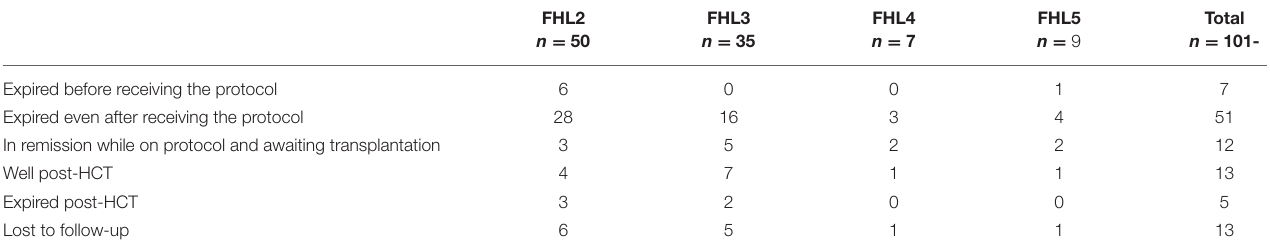
TABLE 3 | Outcome of therapy seen in different FHL